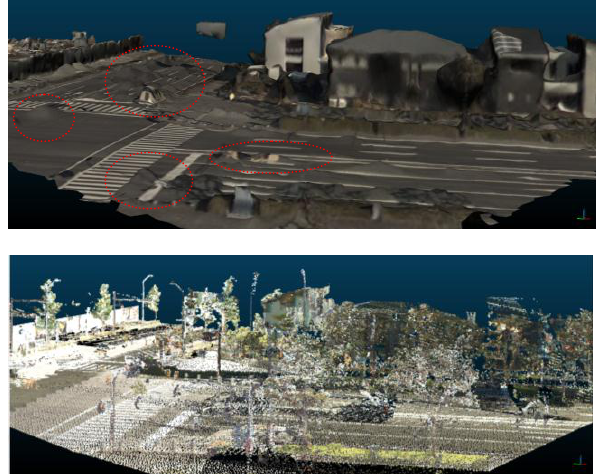
Figure 1. 3D model from aerial imagery (top) & MMS RGB point cloud (bottom) of the same area